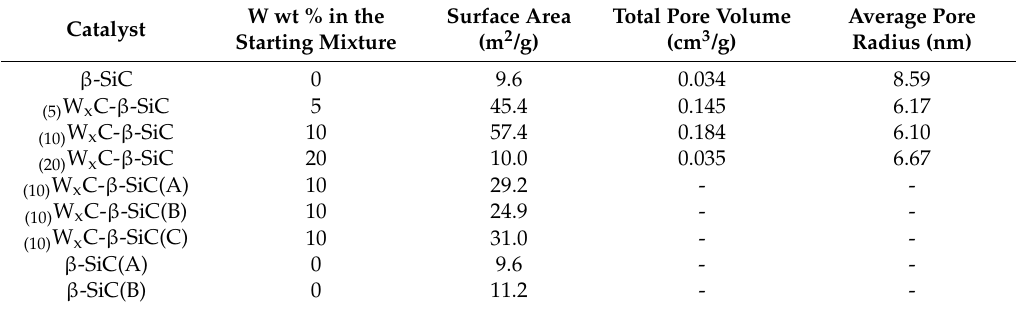
Table 3. Specific surface areas and textural properties of the catalysts used in the experiments.